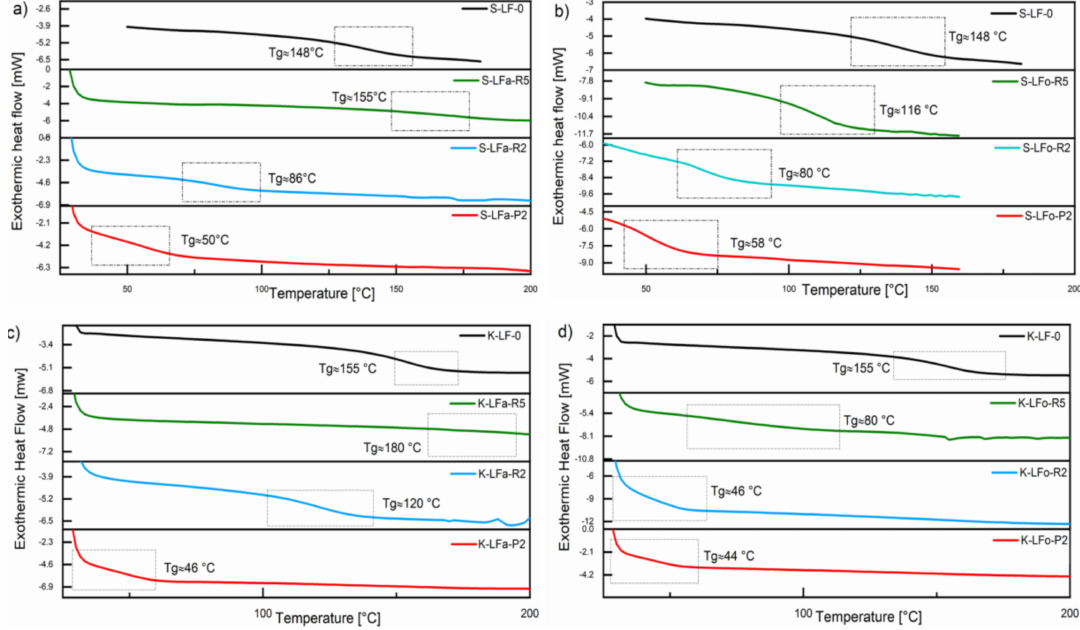
Figure 11. DSC traces of soda ( a , b ) and kraft ( c , d ) lignin fractions recovered from the aqueous process ( a , c ) and the organic process ( b , d